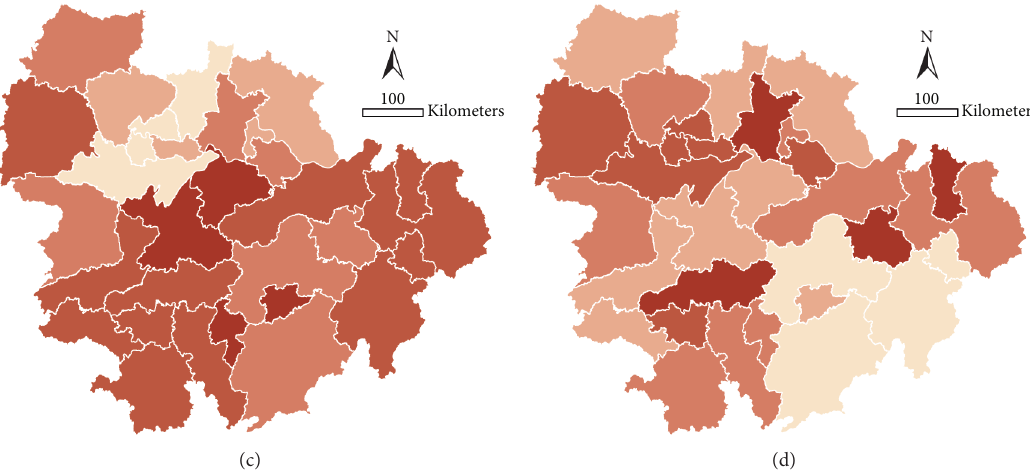
Figure 7: Landscape metrics of construction land: (a) cls 3-PD; (b) cls 3-AL; (c) cls 3-IJI; (d) cls 3-COHESION.